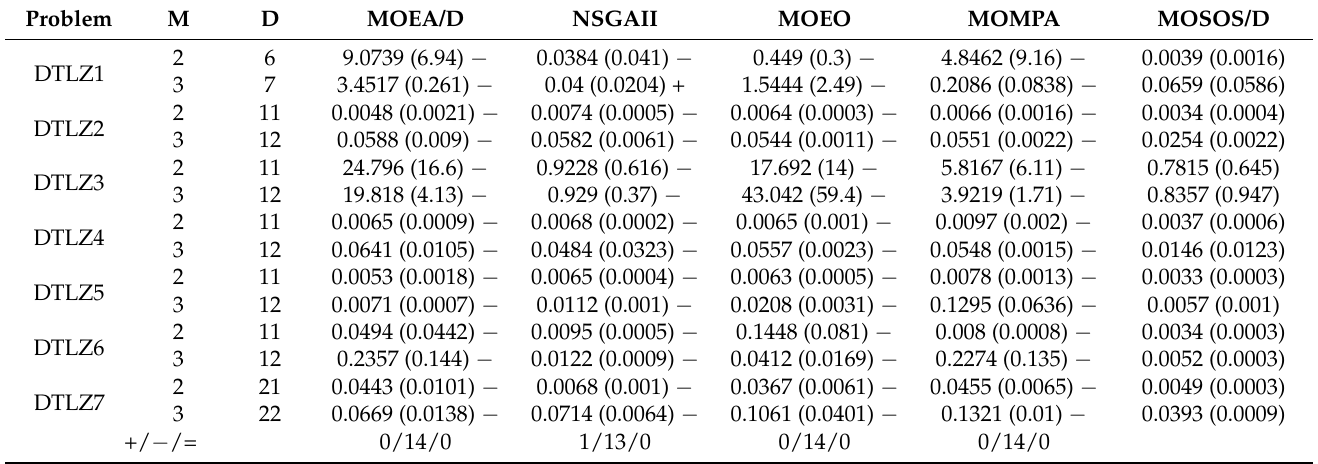
Table 2. The SP (space between non-dominated solutions) metric comparison.